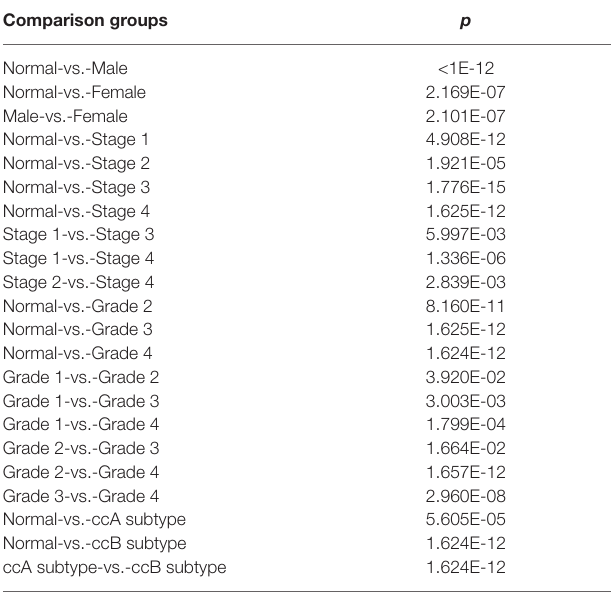
TABLE 2 | Association of PATJ mRNA and ccRCC pathological